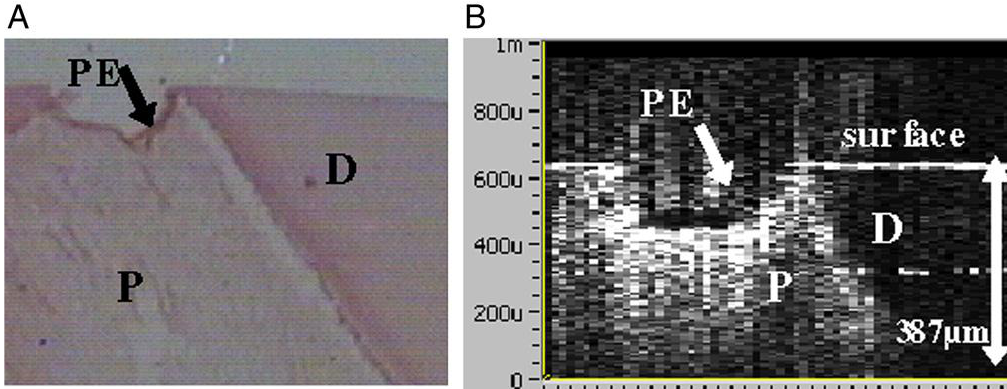
Figure 8. Site of pulp exposure. ( A ) Histologic cross-section of pulp exposure. ( B ) The pulp and dentin were clearly delineated in the OCT image (P: pulp; D: dentin; PE: pulp exposure) (reprinted from reference